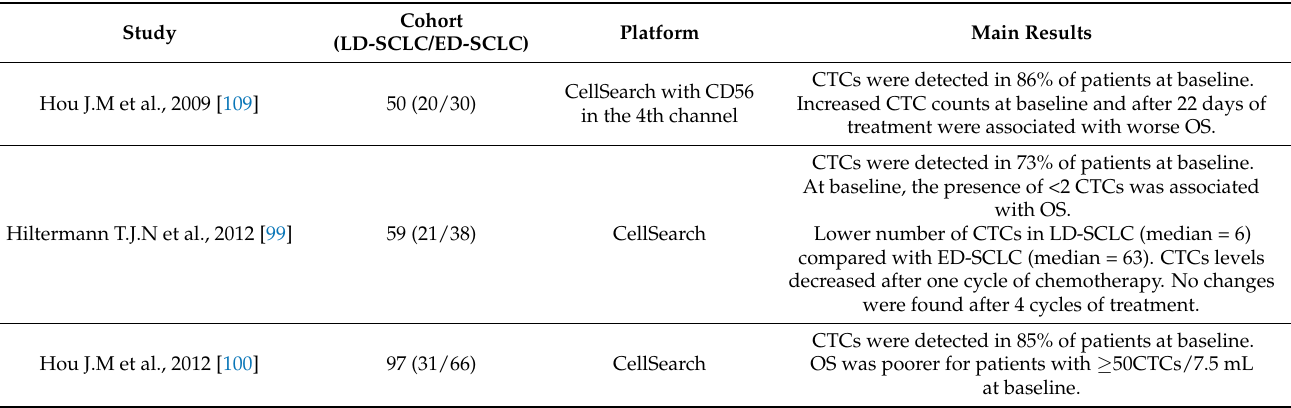
Table 2. Summary of studies that analyzed circulating tumor cells (CTCs) in